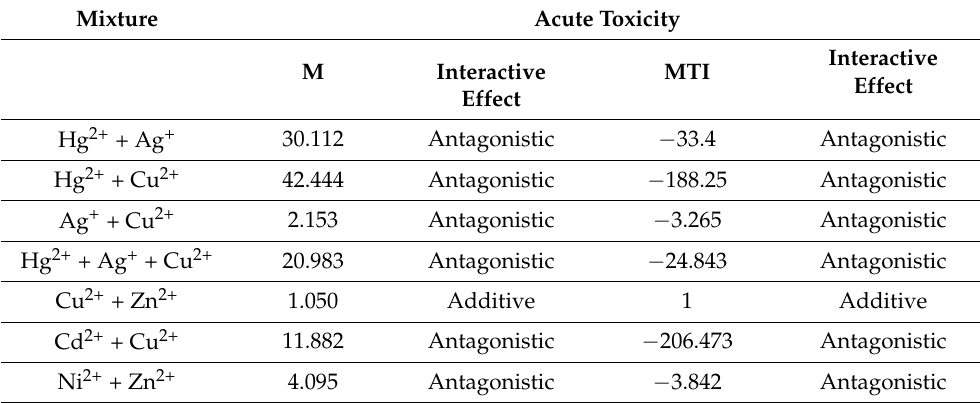
Table 5. MTI approach to determine the acute effects (30 min) of two and three combined heavy metals on Photobacterium